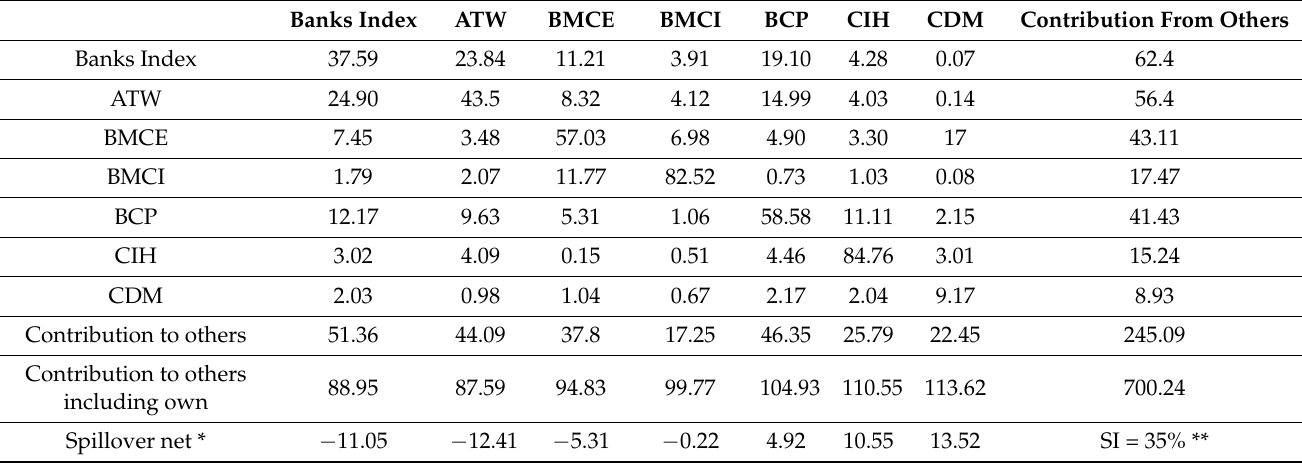
Table 5. Volatility spillover index (during-crisis